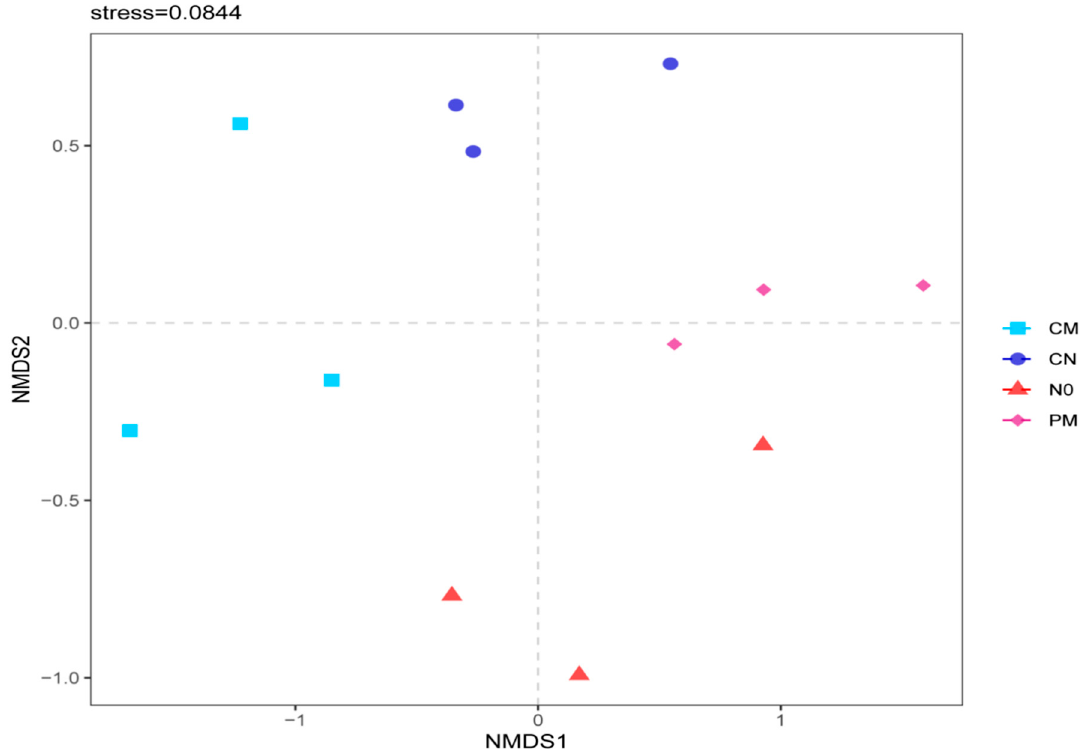
Figure 1. Beta diversity of the soil prokaryotic community of different fertilization regimes. NO: no N fertilizer. CN: 100% urea N with no organic fertilizer. PM: 80% urea N plus 20% N with pig manure. CM: 80% urea N plus 20% N with compost. Beta diversity was analyzed by nonmetric multidimensional scaling (NMDS) based on unweighted UniFrac phylogenetic distance metrics at the OTU level, and displayed in a scatter diagram.